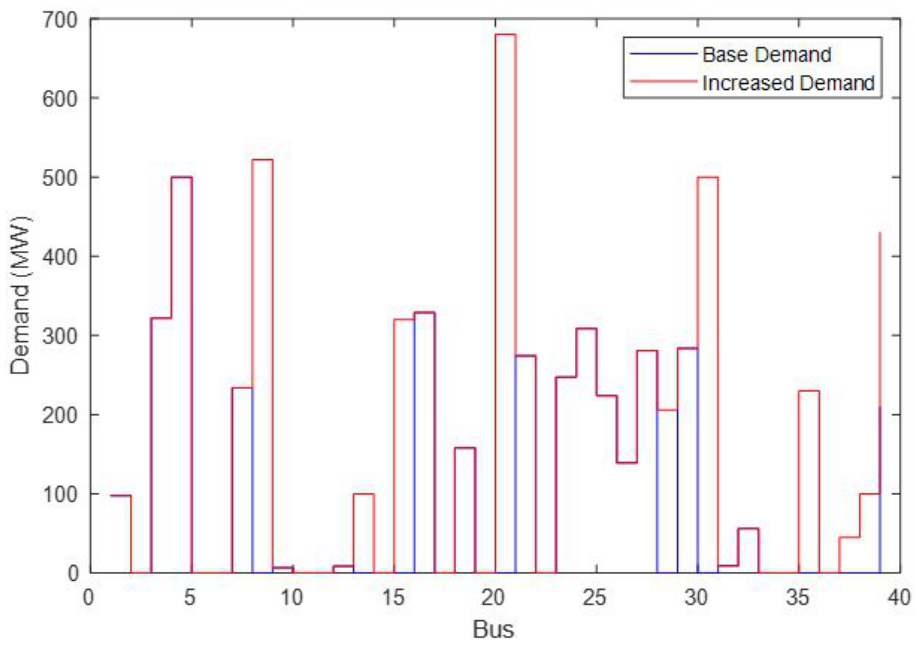
Figure 7. The 39-bus system’s load profile in base and increased demand scenarios